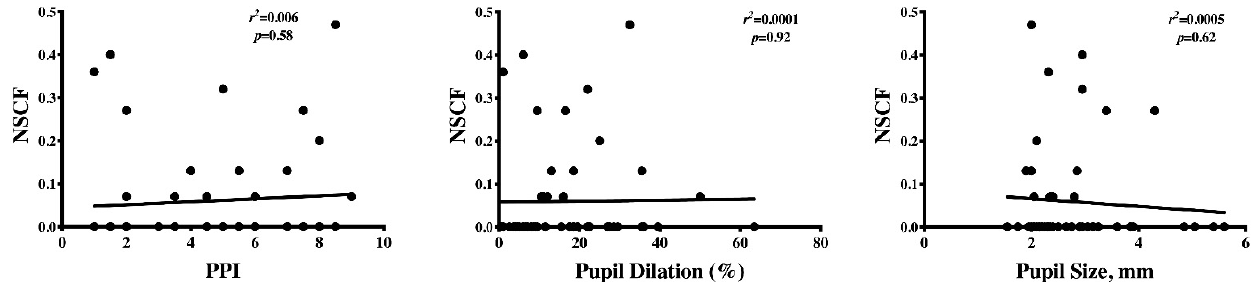
Figure 2. Correlation between the number of conductance fluctuations per second (NSCF) and the pupillary pain index (PPI), the dilation rate (%), and the baseline pupil size (mm) at noxious stimulation.